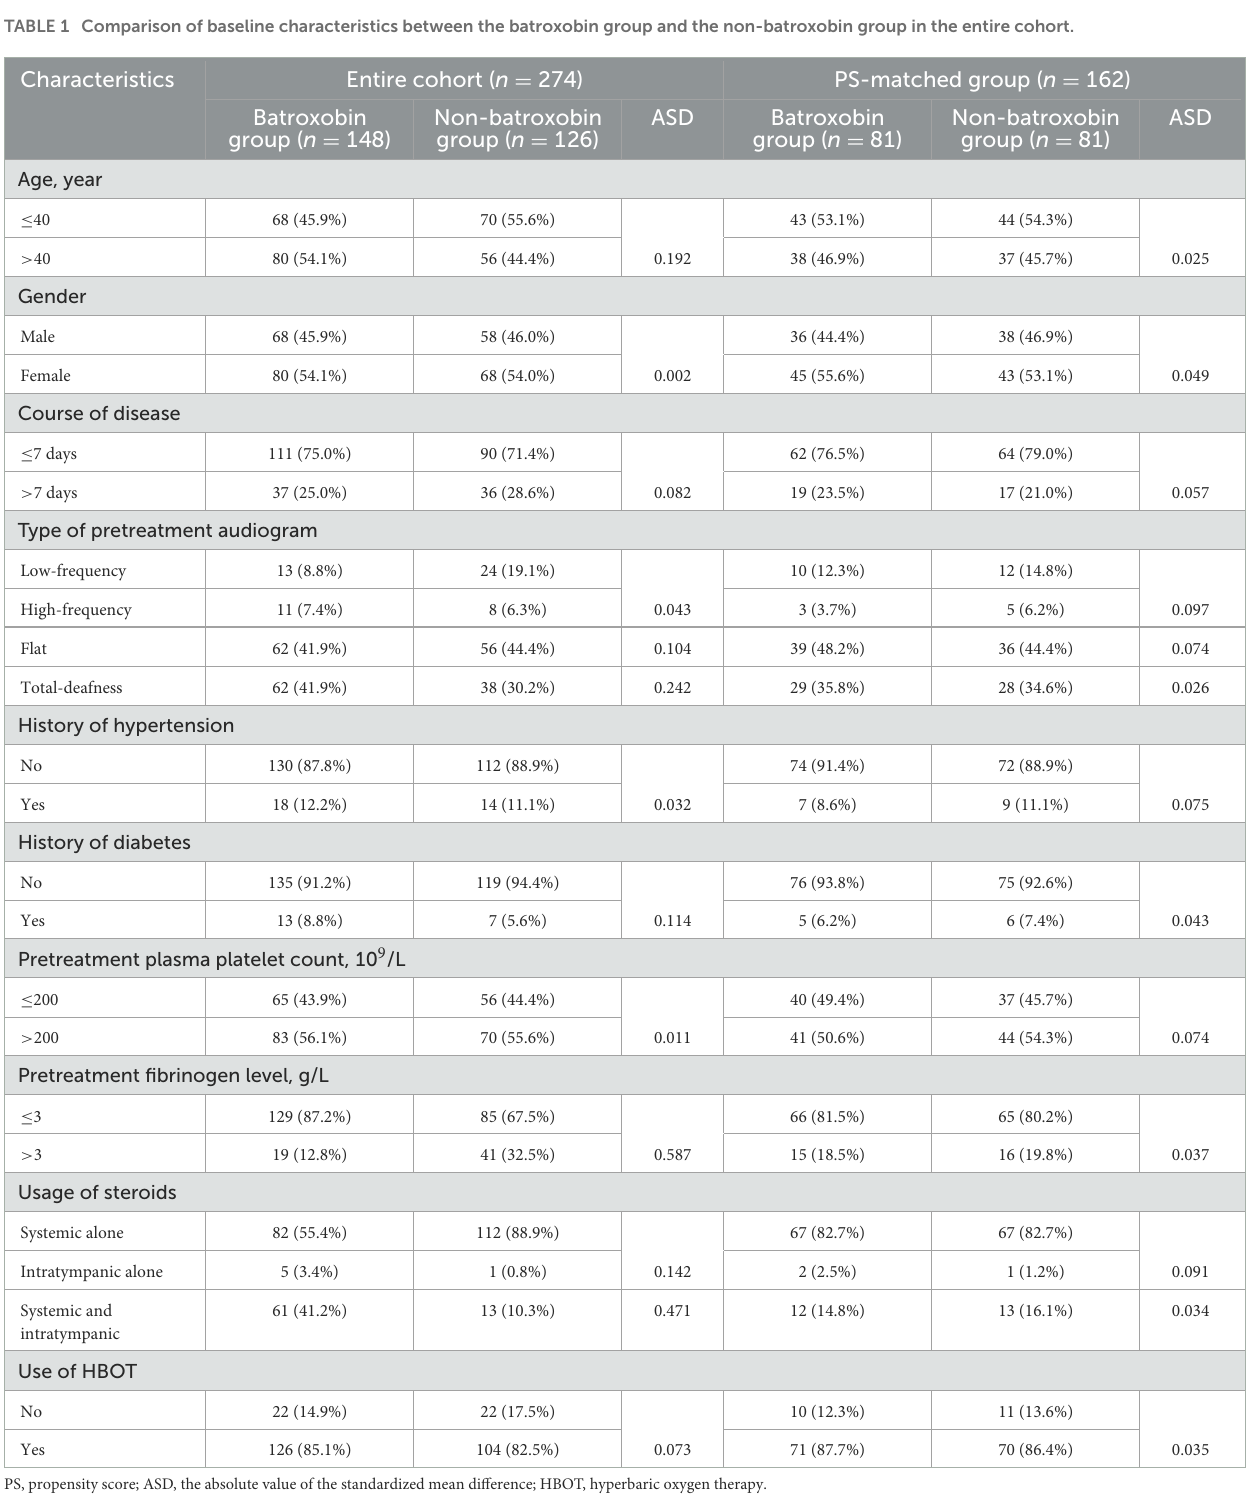
PS,propensityscore;ASD,theabsolutevalueofthestandardizedmeandifference;HBOT,hyperbaricoxygentherapy.